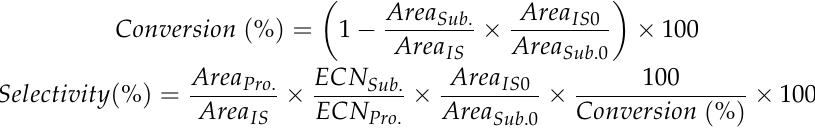
Figure S2: FT-IR spectra (ATR mode); Figure S3: CO 2 fixation to SO promoted by TBA-Ta x Nb 6 − x under N 2 atmosphere under N 2 atmosphere; Figure S4: Results of CO 2 fixation to SO over TBA- Ta x Nb 6 − x ; Figure S5: Time course of CO 2 fixation to SO and selectivity of SC over TBA-Nb 6 ; Figure S6: Optimized structure of [Ta 1 Nb 5 O 19 ] 8 − and CO 2 -adsorbed [Ta 1 Nb 5 O 19 ] 8 − ; Figure S7: In situ FT-IR spectra (ATR mode) of TBA-Ta 1 Nb 5 in DMSO before (black line) and after CO 2